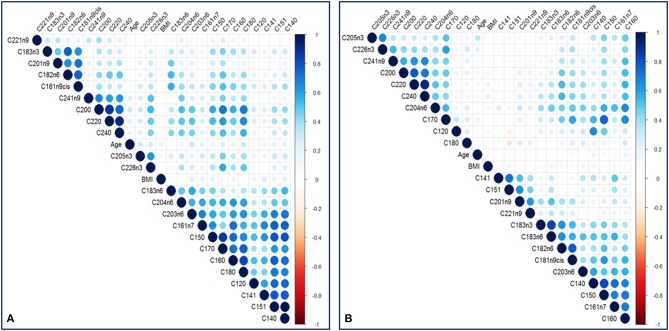
A scatter plot correlation matrix of the main variables used in the model. (A) Case group (B) Control group. Positive correlations are shown in blue and negative correlations are shown in red.